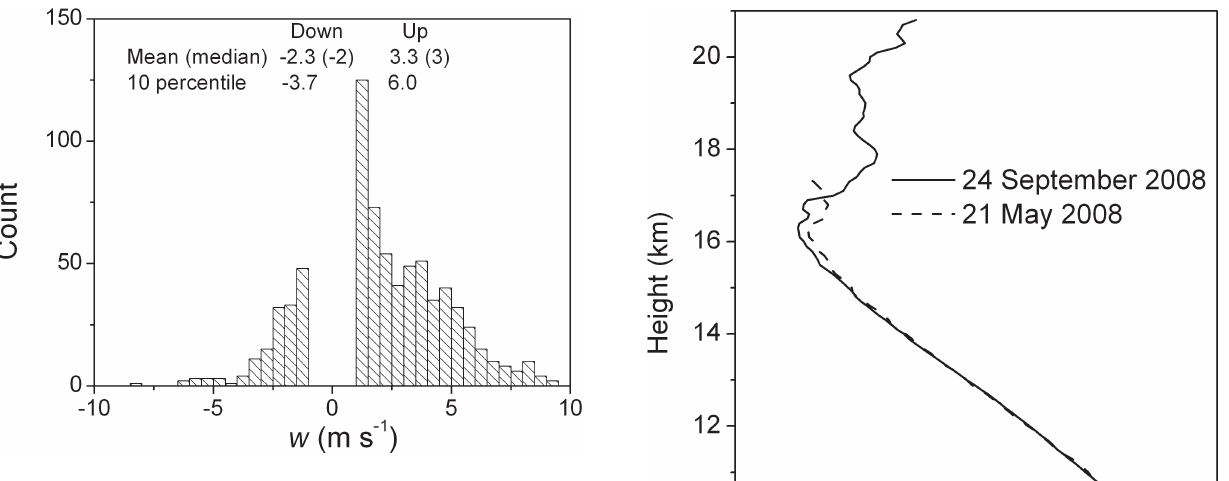
Fig. 3. Distribution of w in draft cores in the tropopause region (16–20km). The mean, median and strongest 10 percentile values of the population are also depicted on figure.